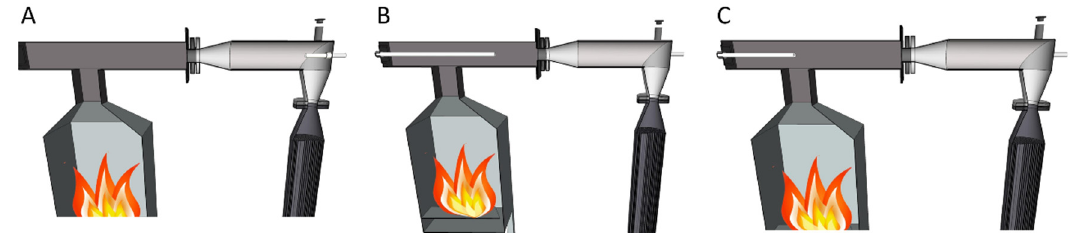
Figure 2. Shielded corona charger (SCC) design and installation locations at ( A ) 300–400 °C and 400–500 °C when SCC chamber was not insulated and with insulation, respectively, ( B ) 600–700 °C, and ( C ) 800 °C.